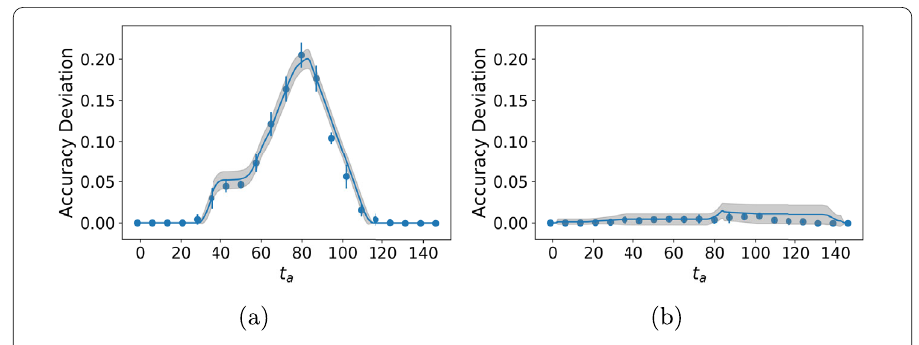
Figure 3 Accuracy deviation curve for COVID-19Air data. ( a ) Using random forest classifier; ( b ) Using a MLP classifier. The scatter points are accuracy deviation measured on testing set and the solid lines are fitted using the proposed accuracy deviation model